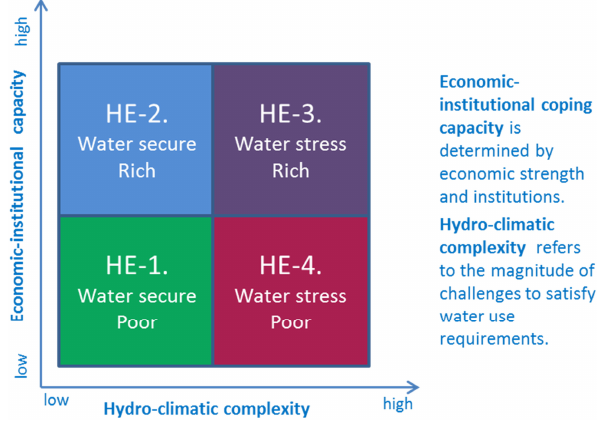
Figure A2. Hydro-economic (HE) quadrants for human–natural water development